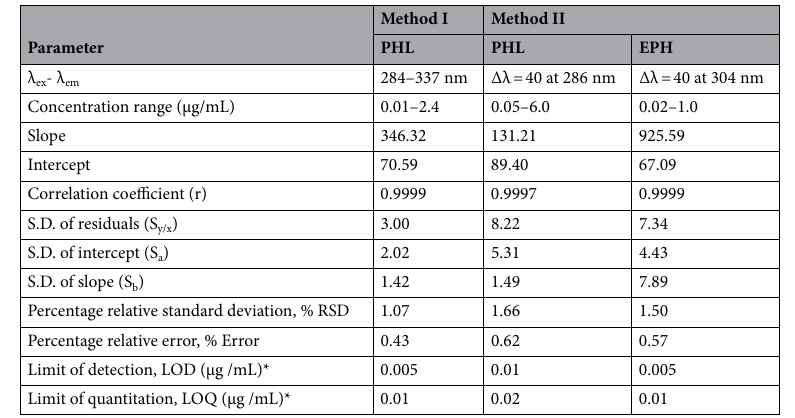
Table 1. Analytical performance data for pholcodine and ephedrine by the proposed spectrofluorimetric methods. *Limits of quantitation and detection were experimentally evaluated.